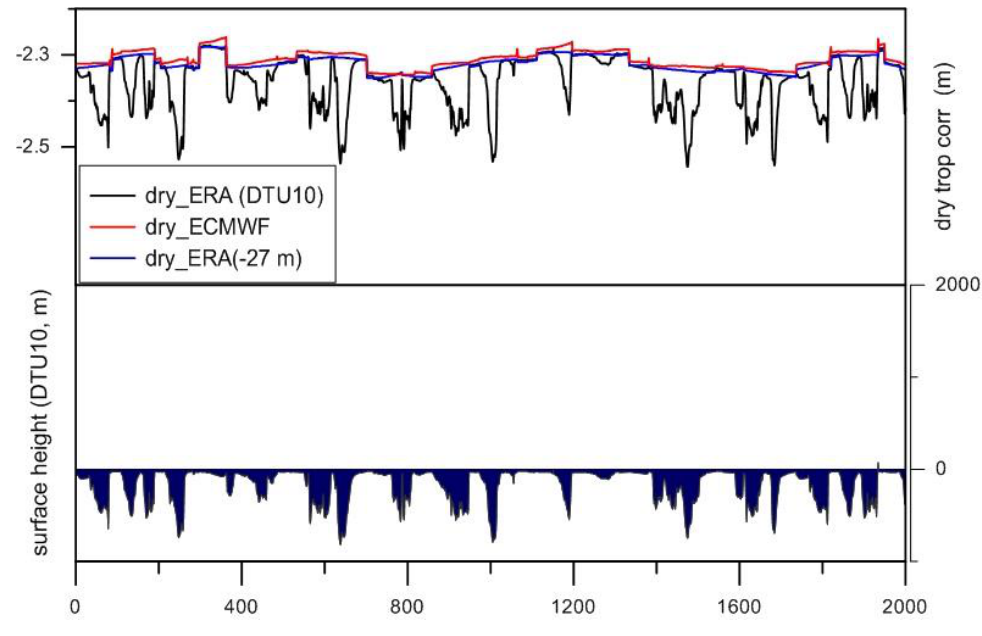
Figure 7. DTC ( top , in m) and surface topography from DTU10 ( bottom , in m) versus the point number by ascending time order, over the Caspian Sea, for SARAL cycles 1 and 2. ECMWF Operational DTC values are those extracted from the IGDRs present in RADS. The blue line represents ERA DTC computed using a mean height of −27 m, while the black line shows the ERA DTC values obtained using the DTU10 topography model in the computation of the height reduction. The difference between the red and blue lines (mean value of 7 mm) reveals that the ECMWF operational DTC was computed using a mean height of 0 m. The DTC from NCEP computed using a mean height of −27 m (not shown) is very similar to the corresponding ERA values (blue